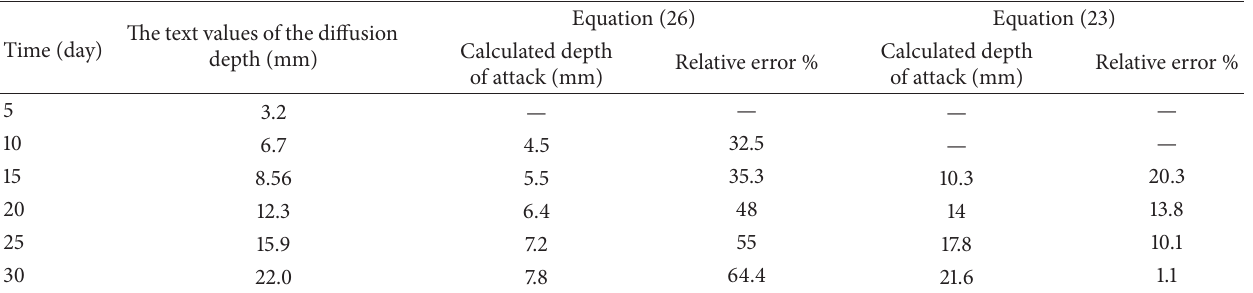
Table 7: Experimental [27] and calculated values of diffusion